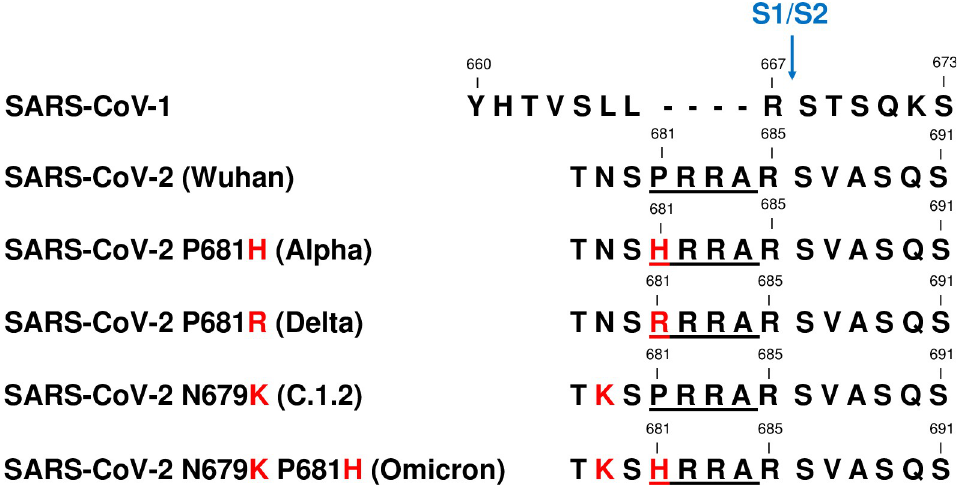
Fig 1. Amino acid alignment of the S1/S2 region of SARS-CoV-1 and SARS-CoV-2 (Wuhan, Alpha, Delta, C.1.2, and Omicron variants). The region corresponding to the S1/S2 cleavage site (blue arrow), four amino acid insert (underlined) and amino acid substitutions of SARS-CoV-2 variants (red) are shown. Accession numbers of sequences are mentioned in the material and methods section.